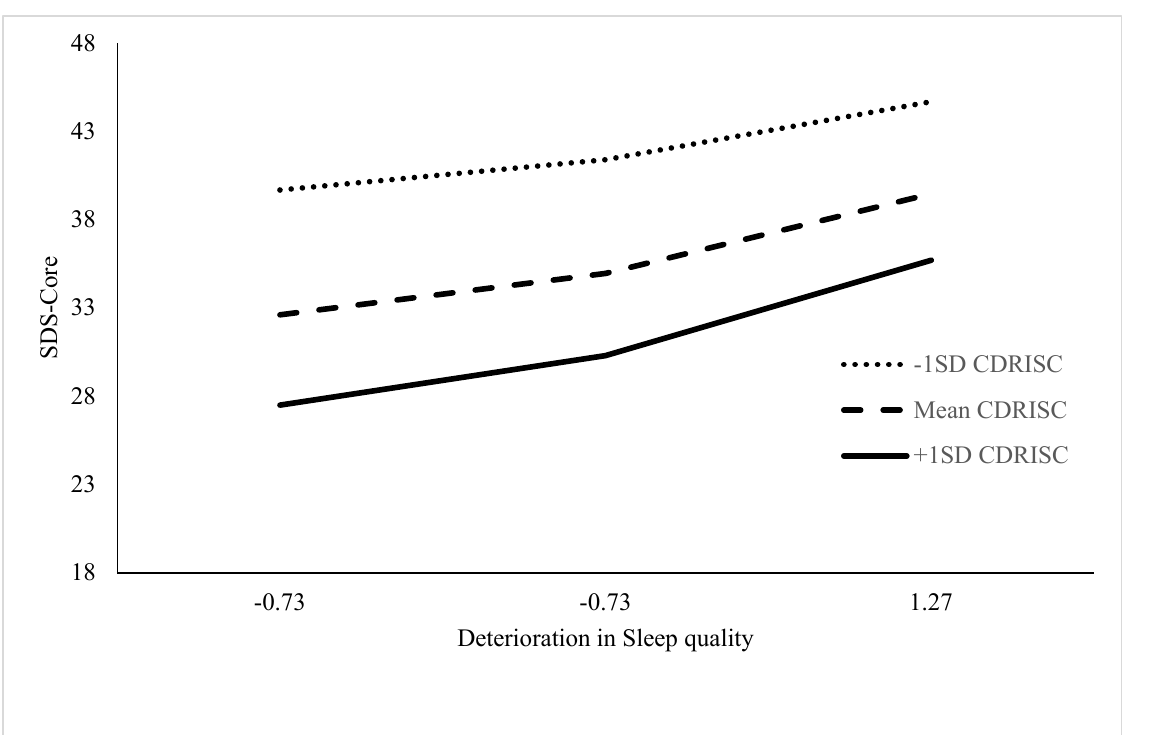
Figure 2. Interaction plot for decreases in sleep quality Item 1, CDRISC-Core, and SDS-Core scores for 55 patients with PCa.